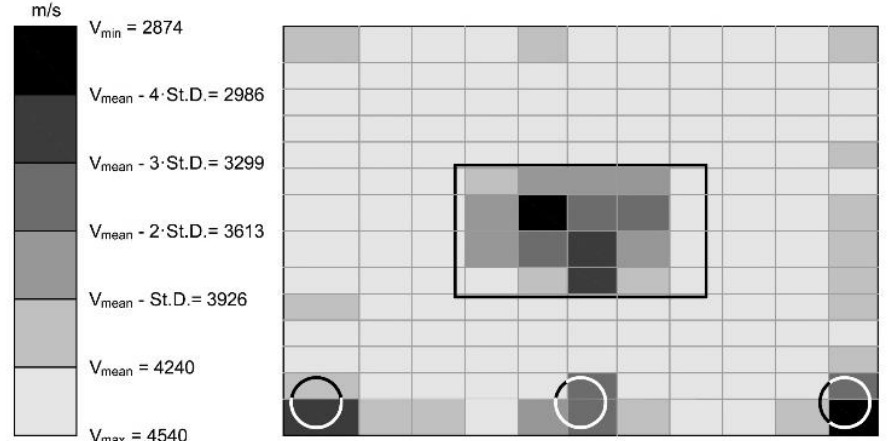
Figure 4. Map 2: Grid B. Levels of velocity.